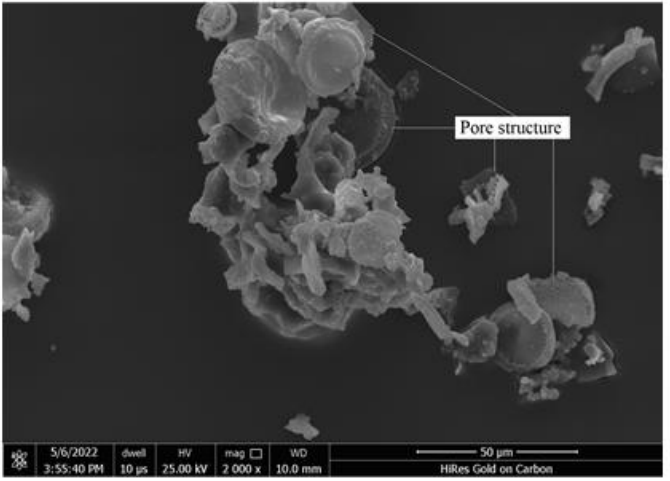
Figure 2. Diatomite suspension.